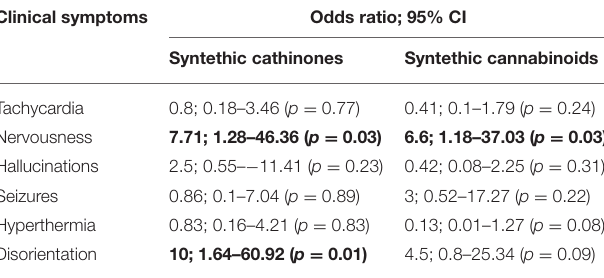
TABLE 3 | Clinical symptoms of synthetic cathinone and cannabinoid intake. Clinical symptoms Odds ratio; 95%